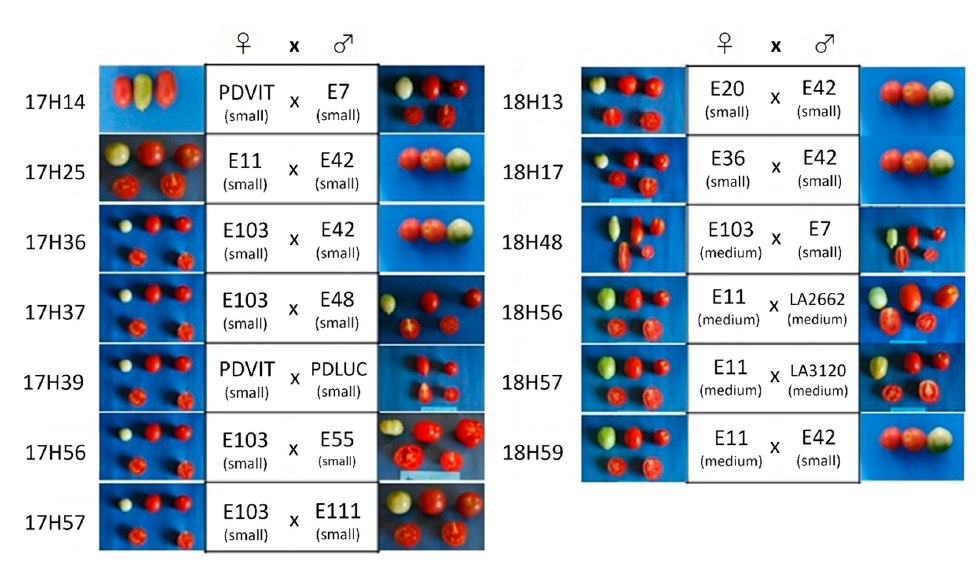
Figure 2. Thirteen F 1 hybrid combinations obtained using 15 different parental genotypes.